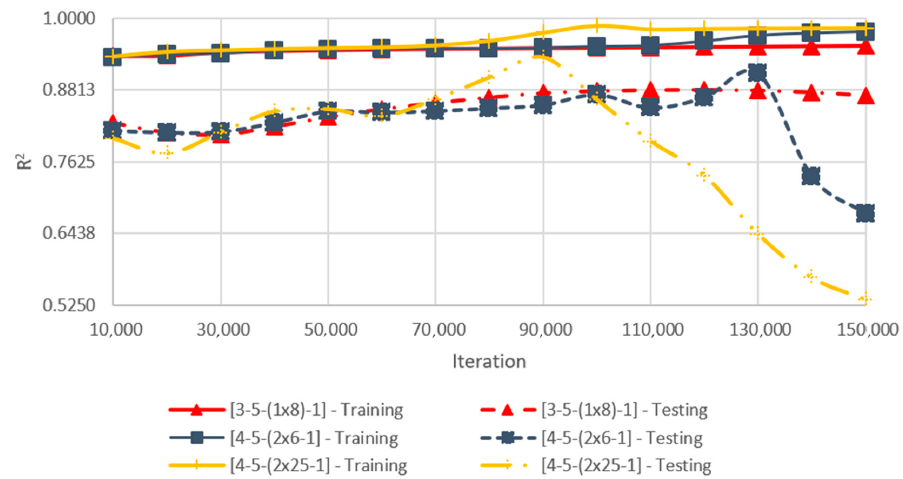
Figure 6. Evolution of correlations with number of iterations in the training phase and validation of the final model with